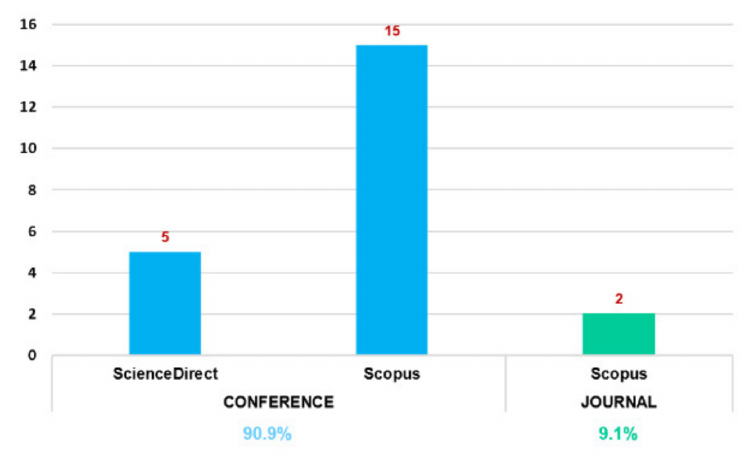
Figure 4. Documents by